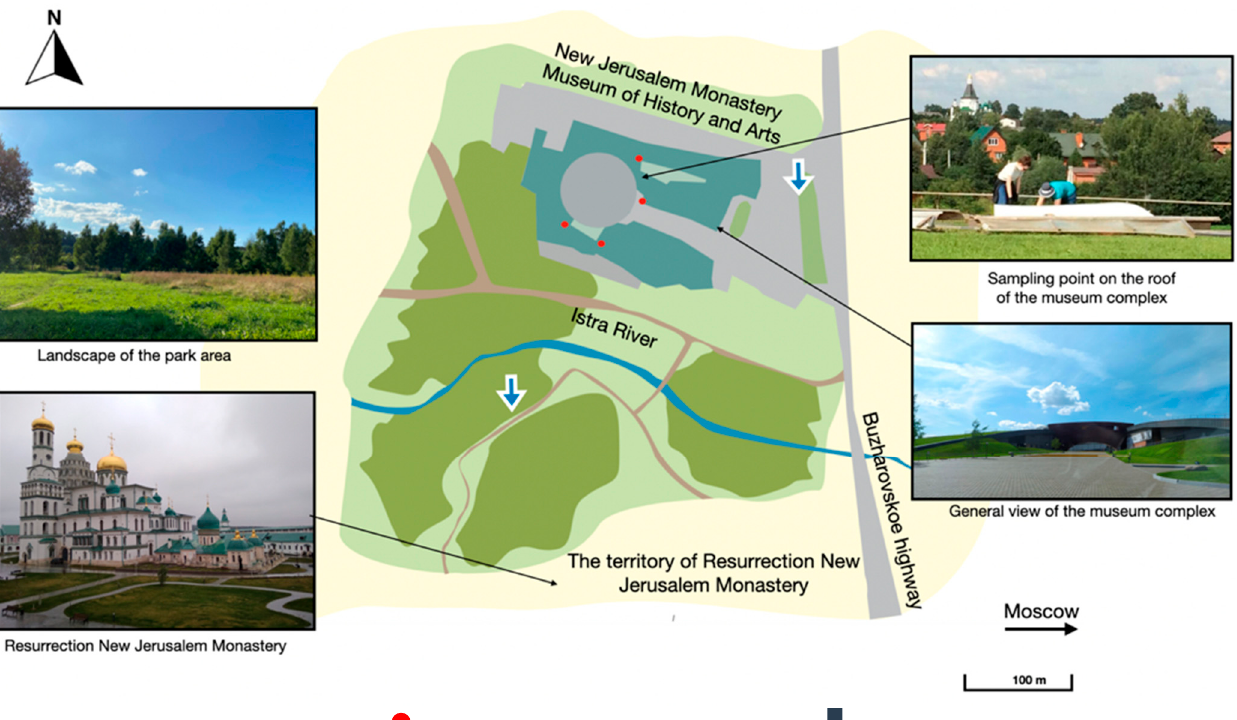
Figure 1. Sampling sites for atmospheric